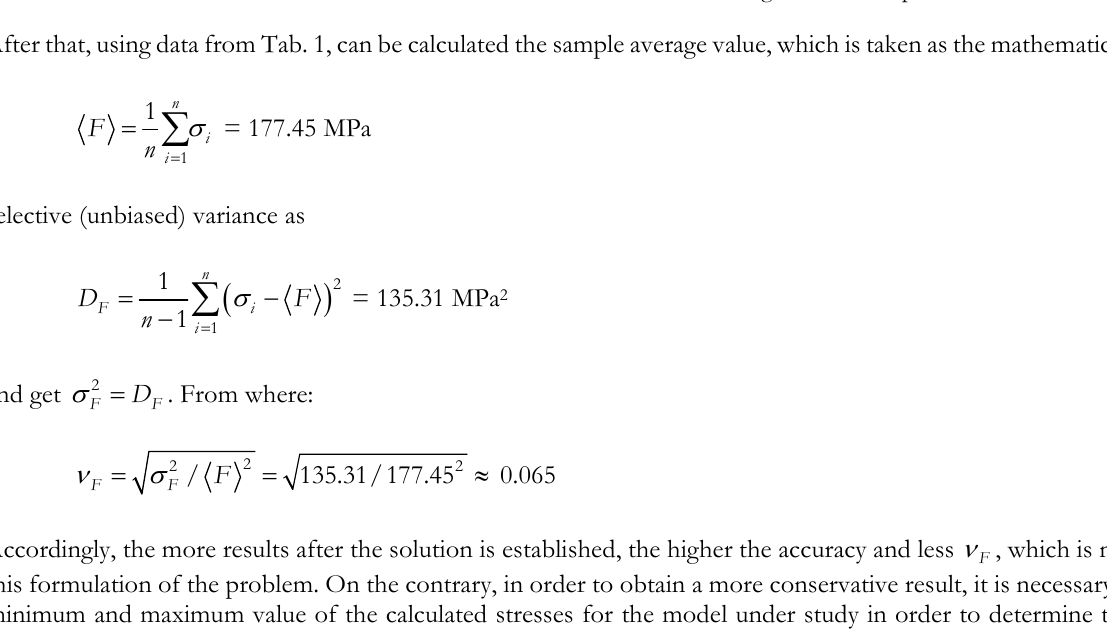
Table 1: The results of FEM calculations for the strength of the